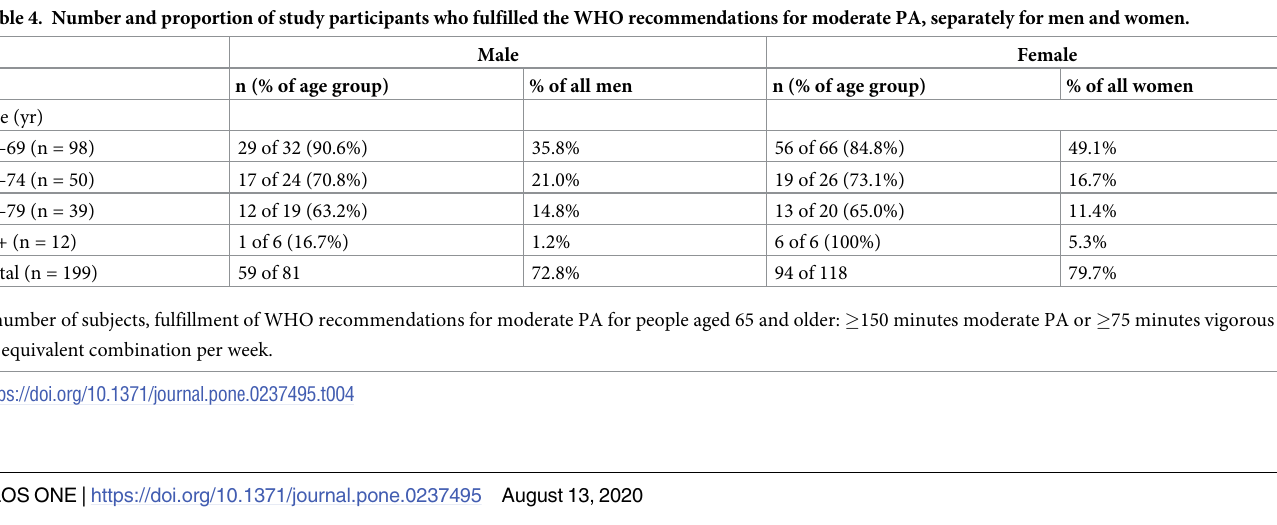
Table 4. Number and proportion of study participants who fulfilled the WHO recommendations for moderate PA, separately for men and women. Male Female n (% of age group) % of all men n (% of age group) % of all women